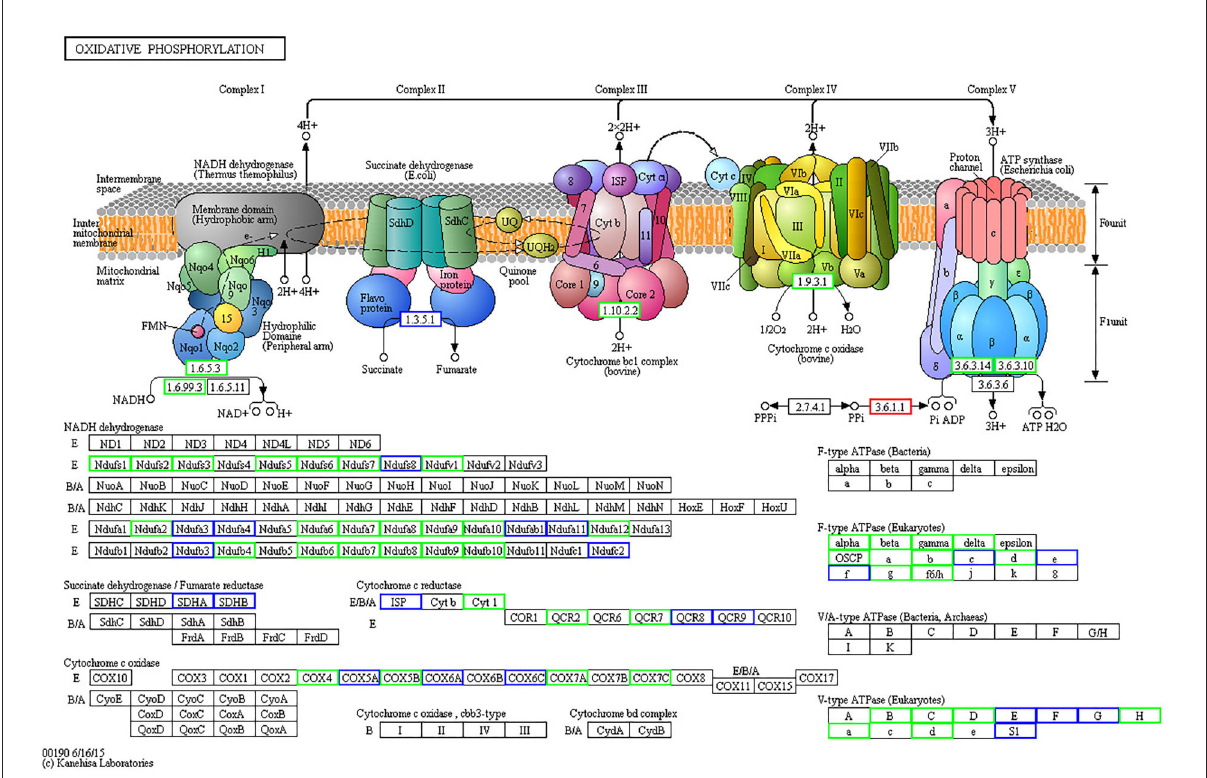
FIGURE5 Differentially expressed proteins in oxidative phosphorylation metabolic pathways between the 15-day and 3-month age groups. Differentially expressed proteins are shown in the KEGG pathway map. The rectangular nodes in the figure represent the gene products (such as enzymes or some RNA regulators). Circular nodes represent compounds (that is, substrates or products). Rectangles with rounded corners on a white background represent the other pathways associated with this pathway. Arrows indicate the direction of an enzyme reaction direction or information transfer. The solid line represents a direct action, and the dotted line represents an indirect action. For more details, please refer to: http://www.genome.jp/kegg/document/help_pathway.html. All gene products with a blue border are background proteins, whereas gene products with a white background frame represent the proteins that are not identified in this experiment. The gene products with a red border are upregulated proteins detected in this test, and a green border represents downregulated